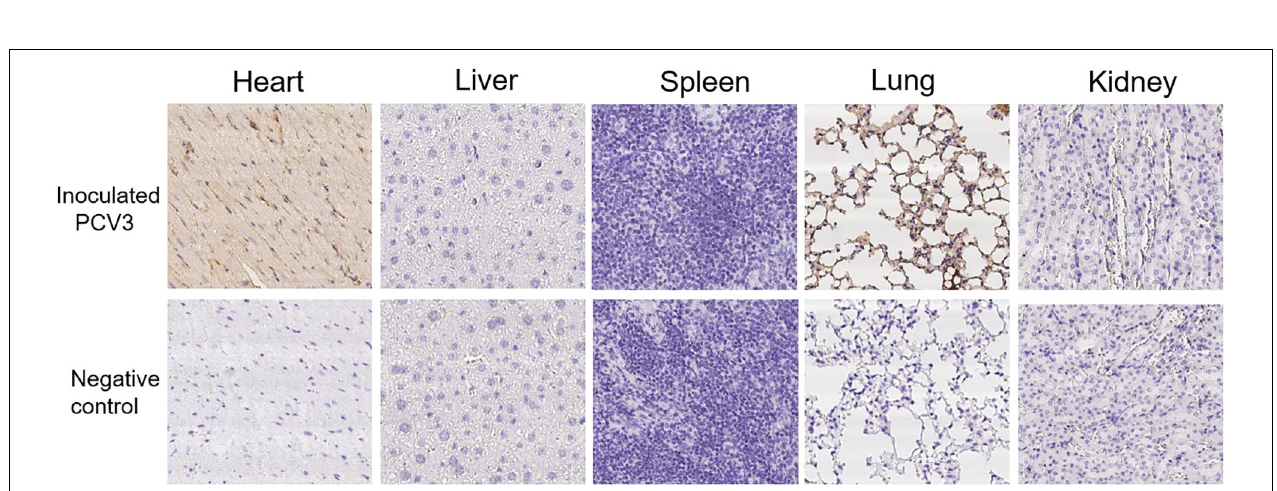
FIGURE 8 | Immunohistochemical staining of organs and tissues of the PCV3-inoculated KM mice. No staining was observed in the heart, liver, spleen, lung, and kidney from no PCV3-inoculated KM mice, and no noticeable staining was observed in the liver, spleen and kidney from PCV3-inoculated KM mice. PCV3 antigen positive cells were brown. A considerable number of positive cells (arrow) for PCV3 antigen were observed in heart and lung tissues of the PCV3-inoculated KM mice.